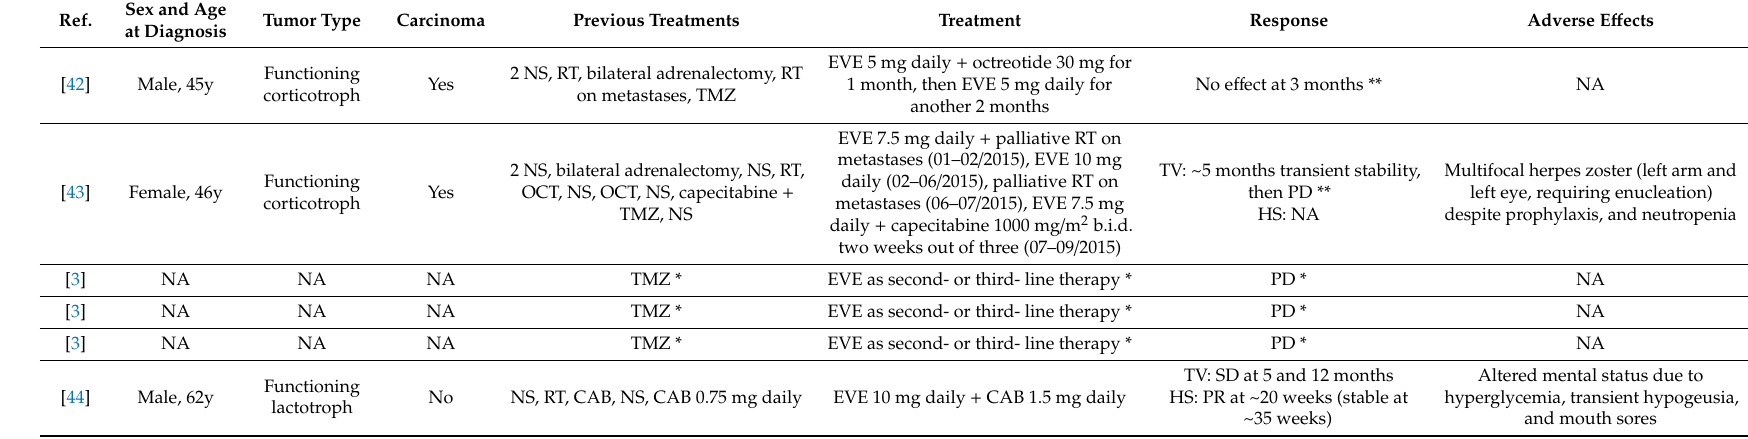
Table 3. Cases of aggressive pituitary neuroendocrine tumors and pituitary carcinomas treated with everolimus (EVE).